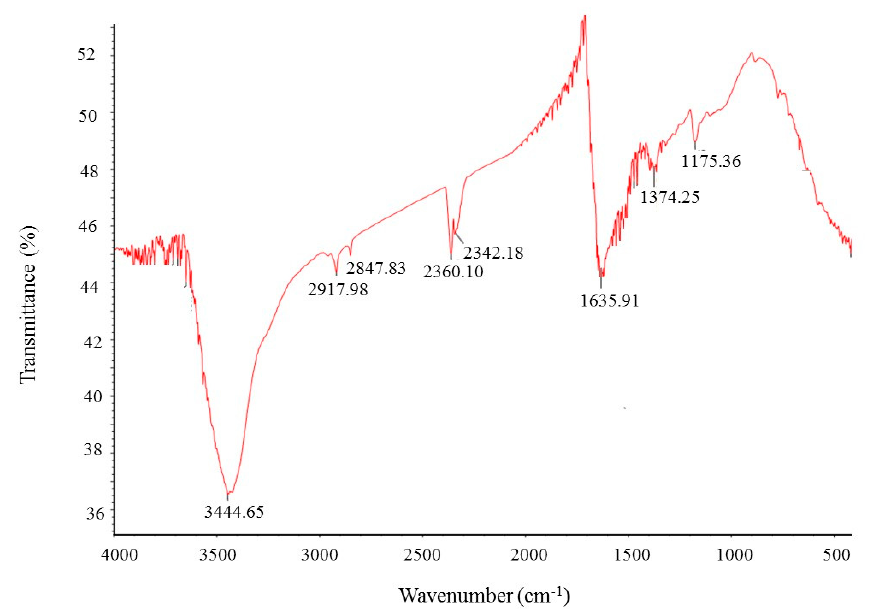
Figure 6. Fourier transform infrared (FT-IR) spectra of ecofriendly synthesized silver nanoparticles.